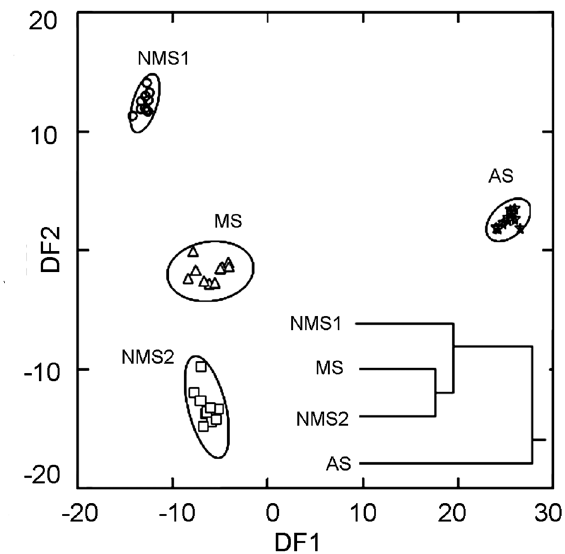
Fig. 6. – 95% confidence ellipses of DFa scores for cuttlebone chemistry and uPgma dendrogram based on euclidean distance. mS, marmara Sea; aS, aegean Sea; nmS1, north- eastern mediterranean Sea (antalya Bay); nmS2, north-eastern mediterranean Sea (iskenderun